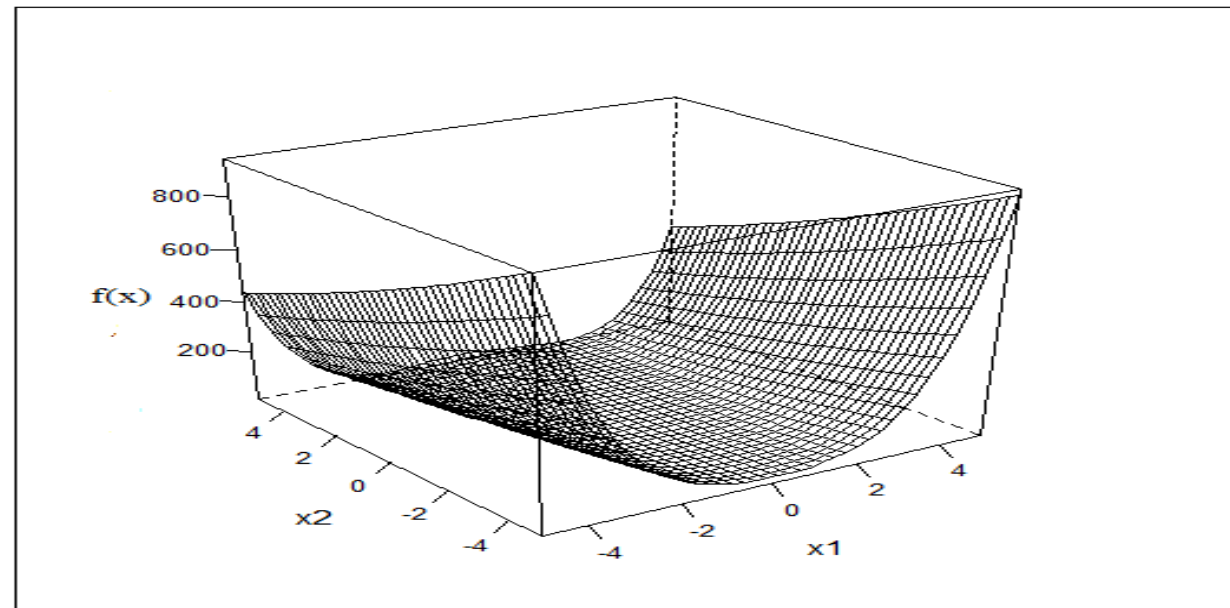
Figure 5. Graphics of Example